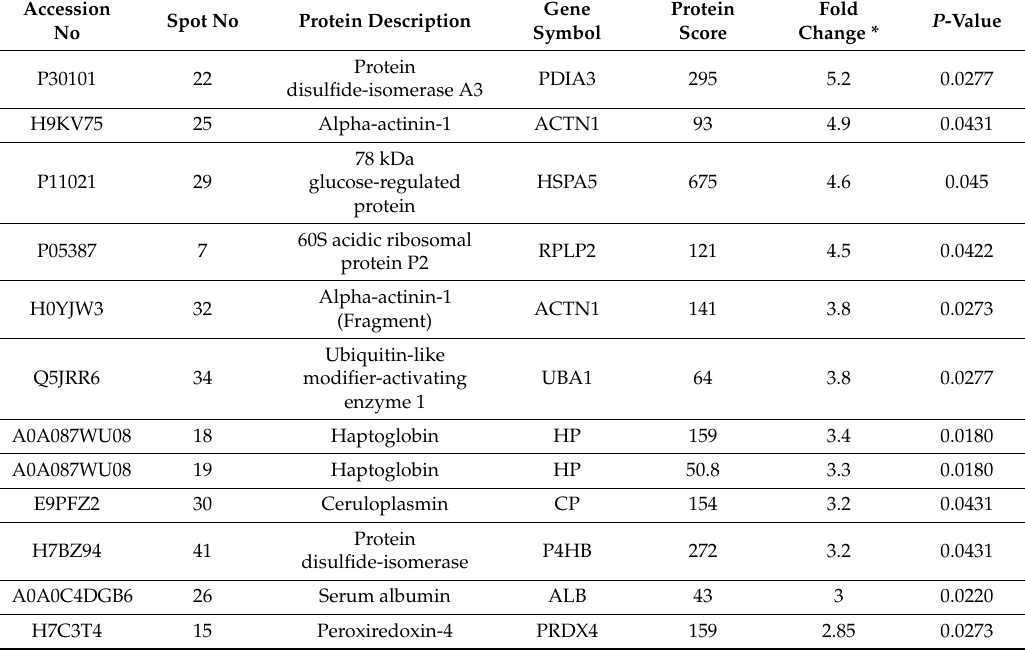
Table 1. List of putative phosphoproteins with a significant di ff erent abundance in the leiomyoma compared to myometrium, as identified by mass